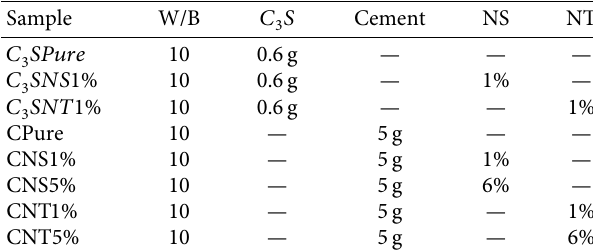
Table 2: Test mix ratio of tricalcium silicate and Portland cement hydration products with different nano-content